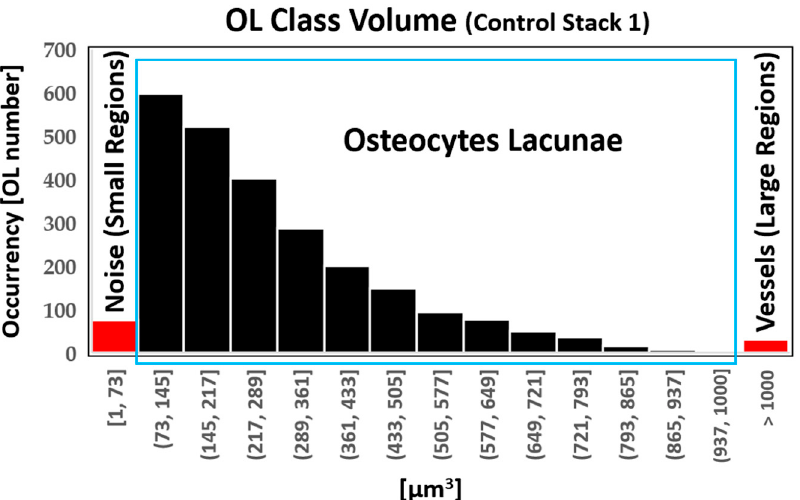
Figure A2. Distribution of the individuated Osteocytes lacunae (OL) in the bone solid phase. Red bar shows the objects smaller than 73 µm 3 classified as noise (objects smaller than 27 voxels that have been re-added to the solid phase) and small pores (objects within 28 and 100 voxels not classified as OL), and the objects bigger than 1000 µm 3 classified as blood vessels. The light blue square indicates the objects classified as OL.